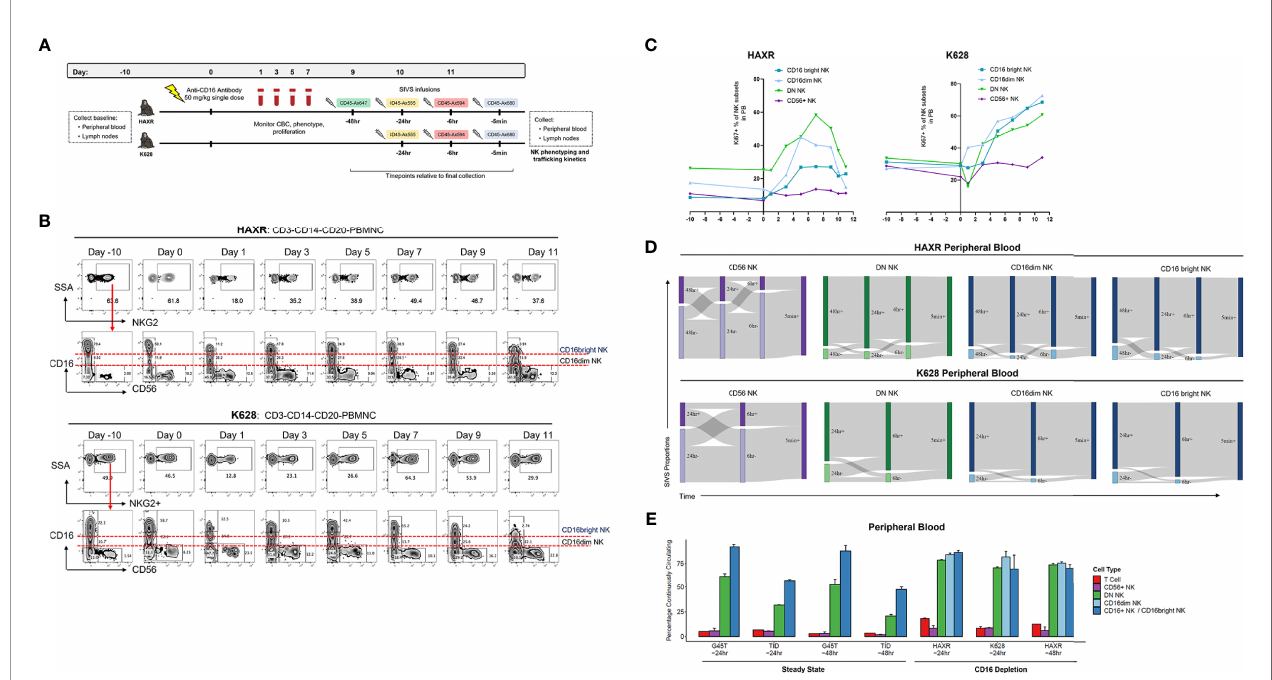
FIGURE 5 | CD16 depletion. (A) Experimental diagram of tissue sampling, administration of CD16-depleting antibody, and time course of SIVS infusions. (B) Percentage of NKG2+ cells (top) and CD56/CD16 distribution (bottom) after CD16 depletion for the two animals. De fi nition of CD16 dim and CD16 bright NK subsets are shown. Day 0 samples were taken immediately prior to anti-CD16 antibody administration. (C) Percentage KI-67+ proliferating NK cells for each subset over the time course of CD16 depletion for the two animals. (D) Sankey diagram showing the proportion of PB NK cells stained positive/negative at each timepoint for CD16 depletion animals HAXR and K628. The times listed are hours or minutes before the fi nal collection. (E) “ Continuously circulating ” is de fi ned as staining positive for all timepoints up to the timepoint listed below the animal name. Bars show the mean and error bars show the standard error of the mean between 2 technical replicates for each NK cell sample. For CD16 depletion animals, the CD16+ NK cells are broken up into CD16 dim and CD16 bright NK as shown in panel (B)